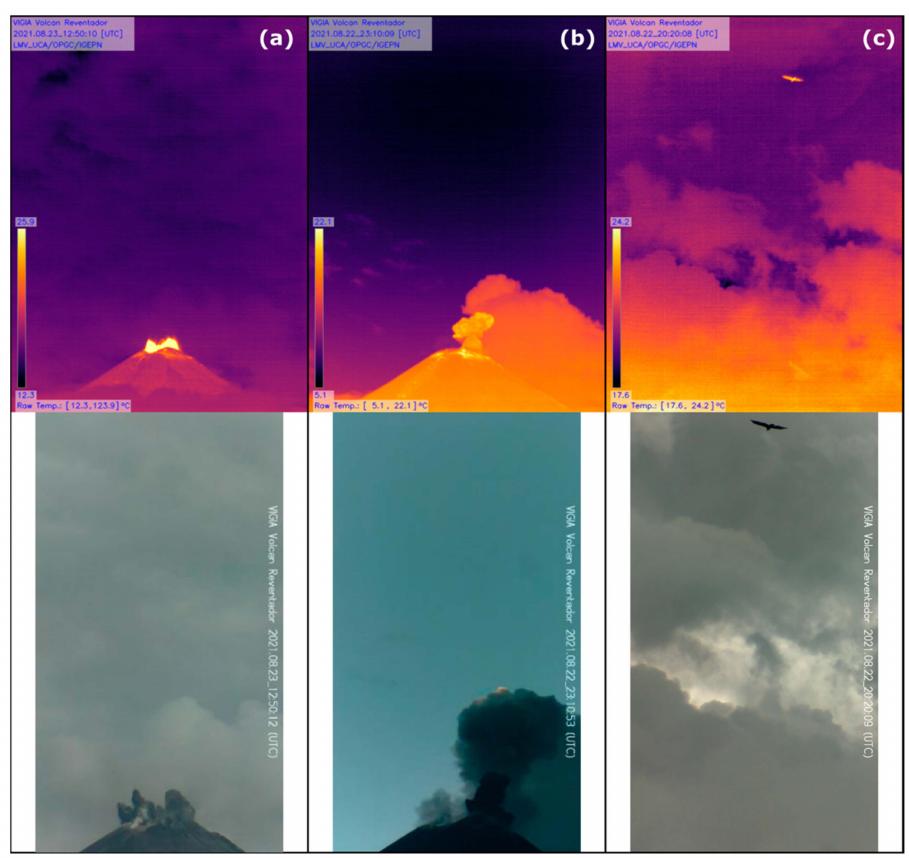
Figure 6. Examples of thermal and visible images captured individually showing different instants of explosions at the Reventador volcano. ( a ) Beginning of the explosion. ( b ) A second pulse of the explosion; note that the different ilumination of the background plume does not mean a difference in temperature. ( c ) Many false events triggered by non volcanic events, a bird in this case, led us to change the triggering system from a simple threshold to a method based on thermal timeseries (see Thermal